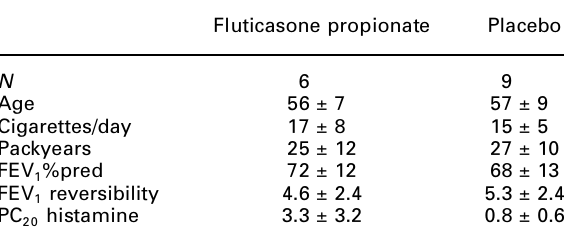
Table 1. Patient characteristics (mean ±SD) Fluticasone propionate